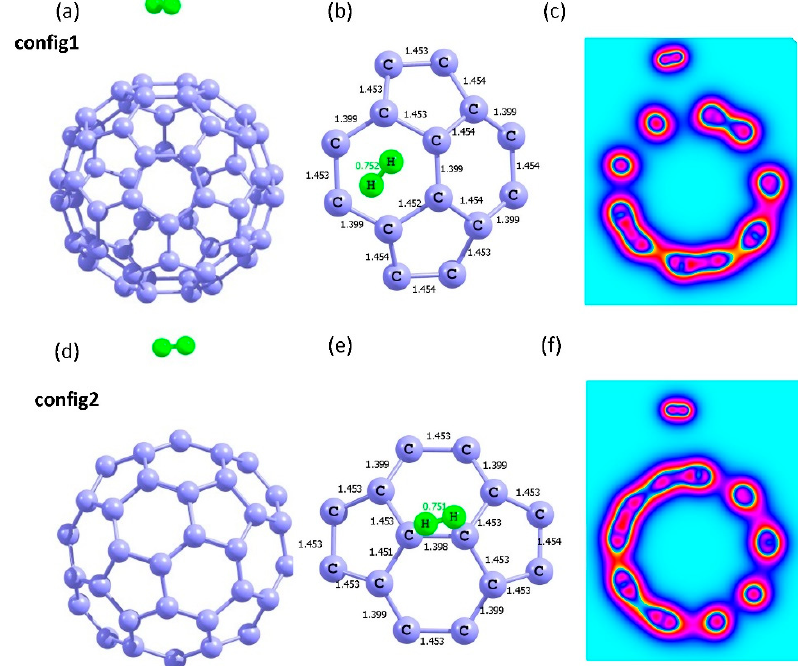
Figure 4. ( a ) Relaxed configuration of molecular hydrogen adsorbed on the surface of pristine C 60 , ( b ) bond distances (H–H and C–C) in the relaxed configuration and ( c ) charge density plot showing the non-covalent interaction. Similar figures ( d – f ) are shown for configuration 2.